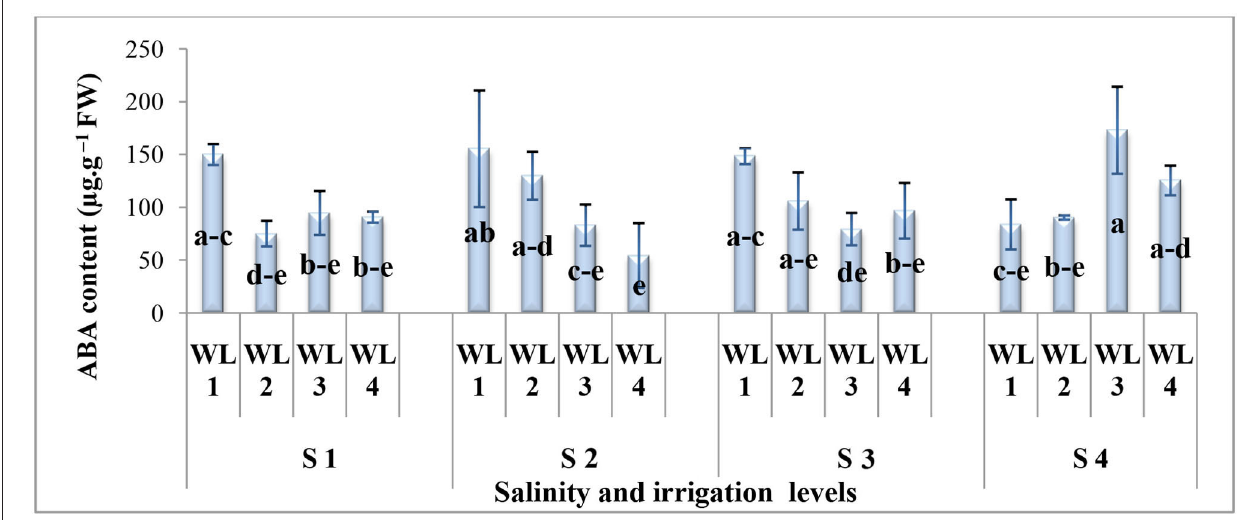
Figure 5 | Interactive effect of salinity and drought stress on the ABA content ( µ g g − 1 FW) of S. imbricata . Value bars with different letters are significantly different from each other at α = 0.05, while error bar represents the standard error of mean ( n = 3). WL stands for water level (WL1 = 100% field capacity, WL2 = 80% field capacity, WL3 = 60% field capacity, and WL4 = 40% field capacity) while S represents the salinity (S1 = 5 dS m − 1 , S2 = 10 dS m − 1 , S3 = 15 dS m − 1 , and S4 = 20 dS m − 1 ).